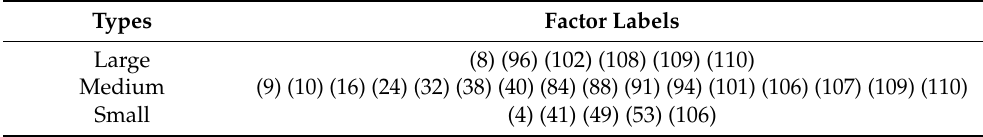
Table 4. Feature ranking of different types of excavator’s market